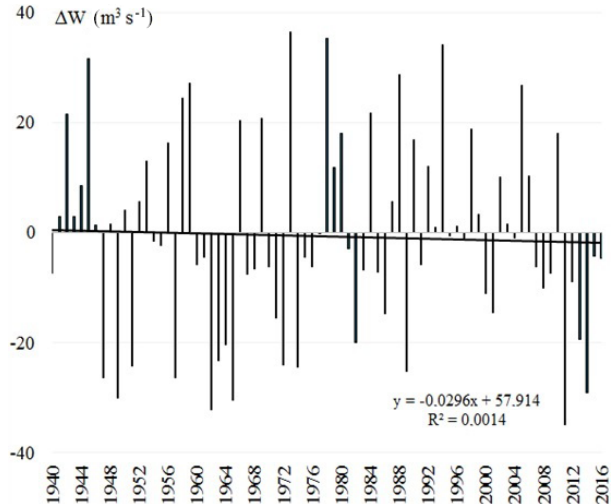
Figure 12. Deviation of annual discharge of the Gunt River from the long-term average (1940–2016) and trend.